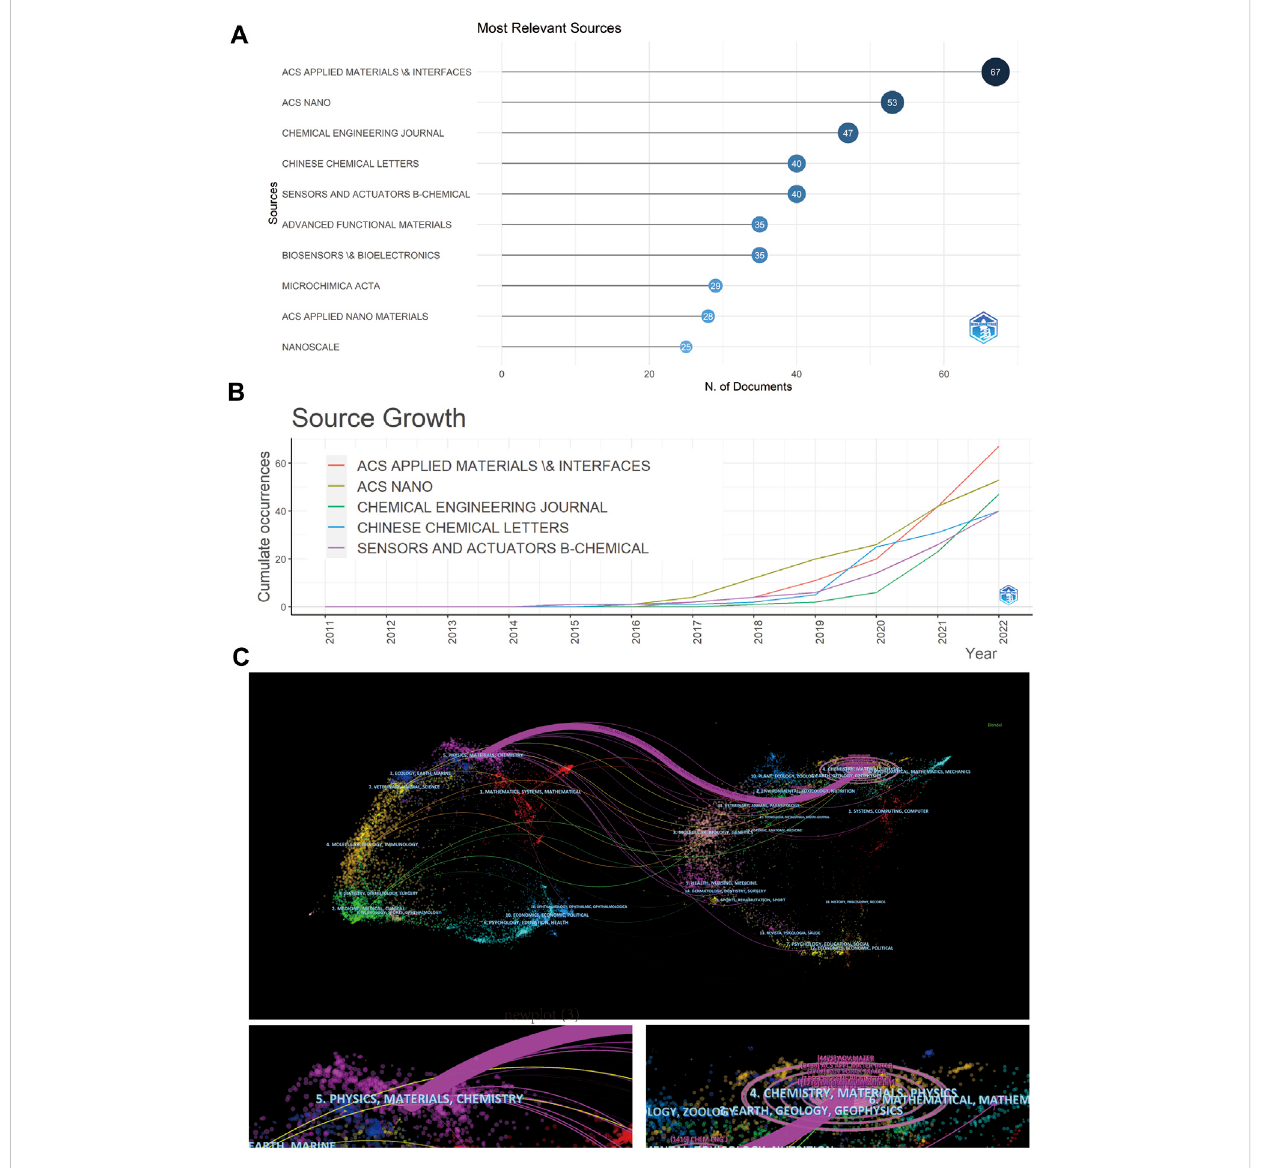
FIGURE 4 Published journals of MXene medical application (A) The journal with the highest total number of publications (B) Number of active journals published per year. (C) The dual-map overlay of articles citing on MXene applications research.